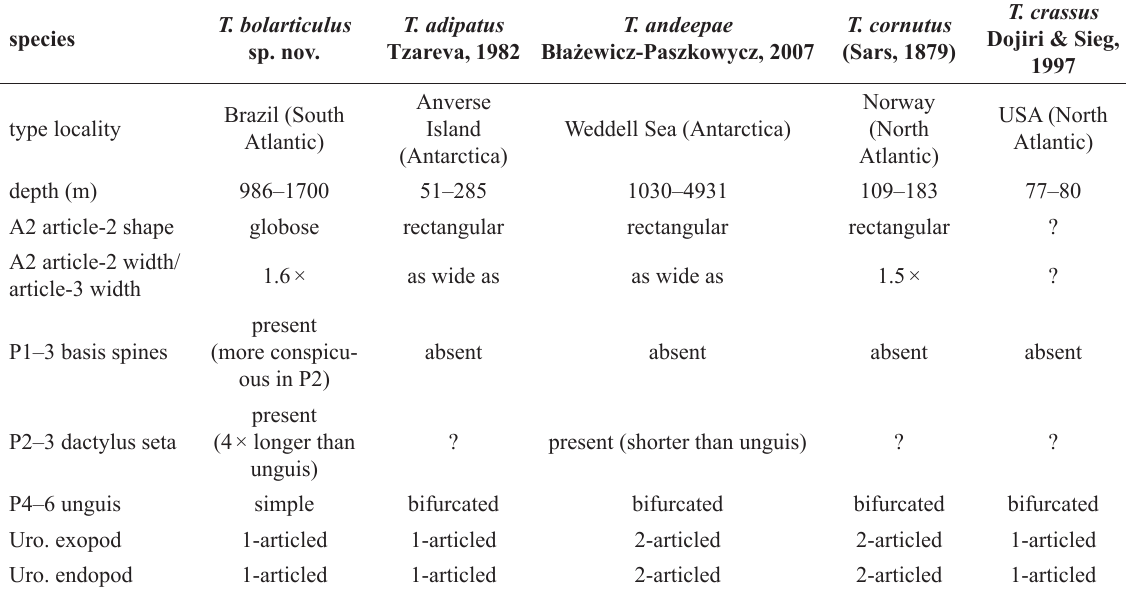
Table 2. Diagnostic characters of species of the Typhlotanais ‘ cornutus ’ group (based on